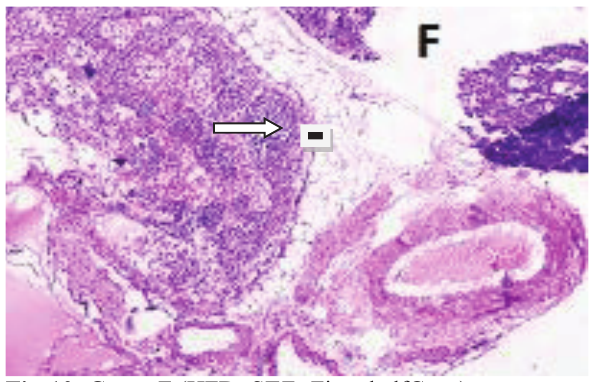
Fig-7: Group C (HFD+STZ+Zinc) Some restoration in size and number of islets with moderate karyolysis and ballooning (40 x; H&E) after treatment with zinc alone